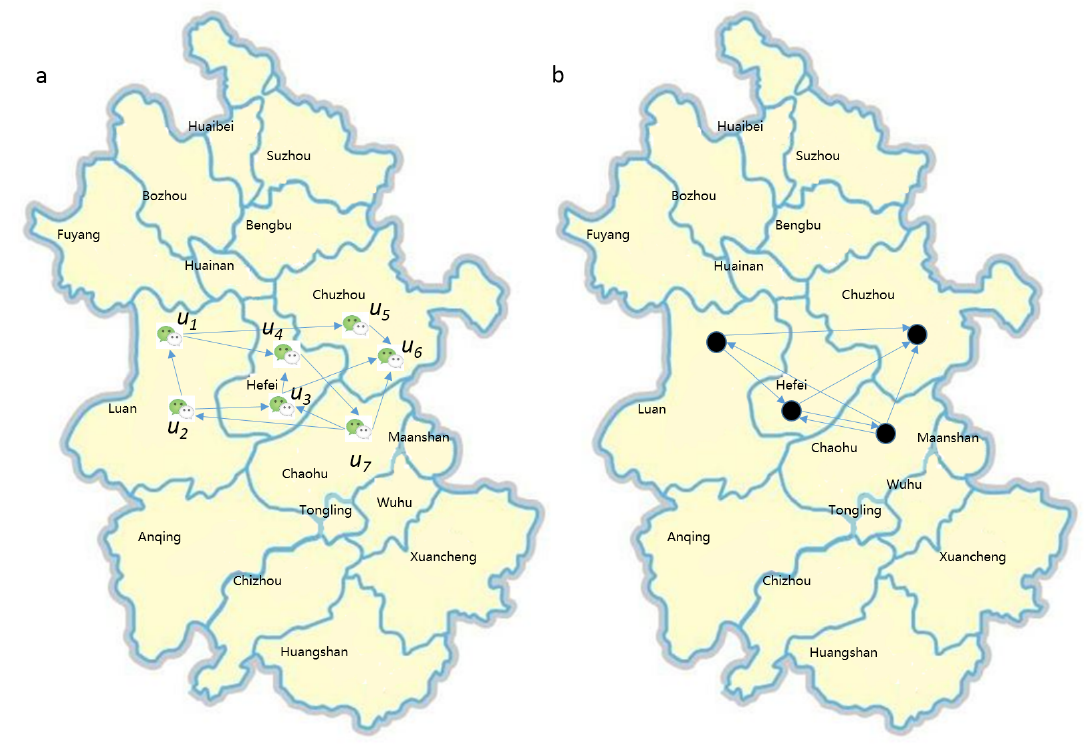
Figure 2. Schematic diagram of network construction. ( a ) The logos of WeChat represents the application users, and the links represent the messages spreading among the users. The users and the links together form a network. ( b ) The users in a city are regarded as an overall entity, and the links from one city to another are regarded as a single link between the respected cities. For example, u 3 and u 4 in ( a ) are integrated into a node hefei in ( b